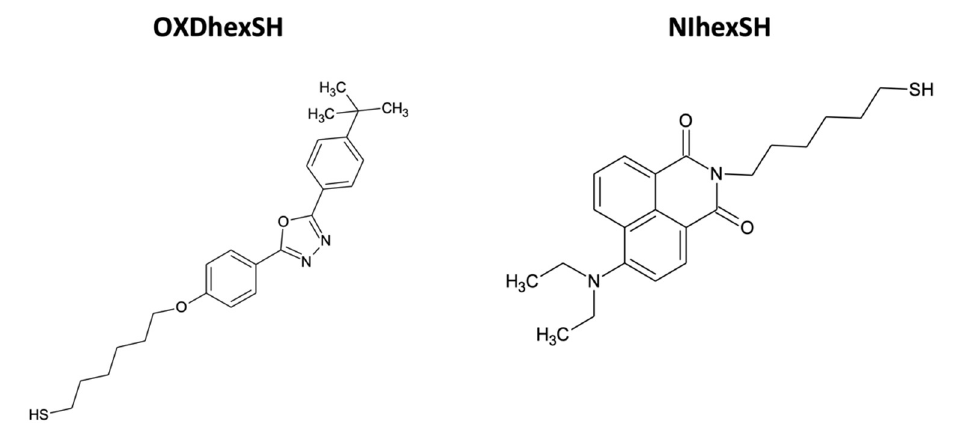
Figure 3. Structural formulas of the OXDhexSH and NIhexSH ligands.